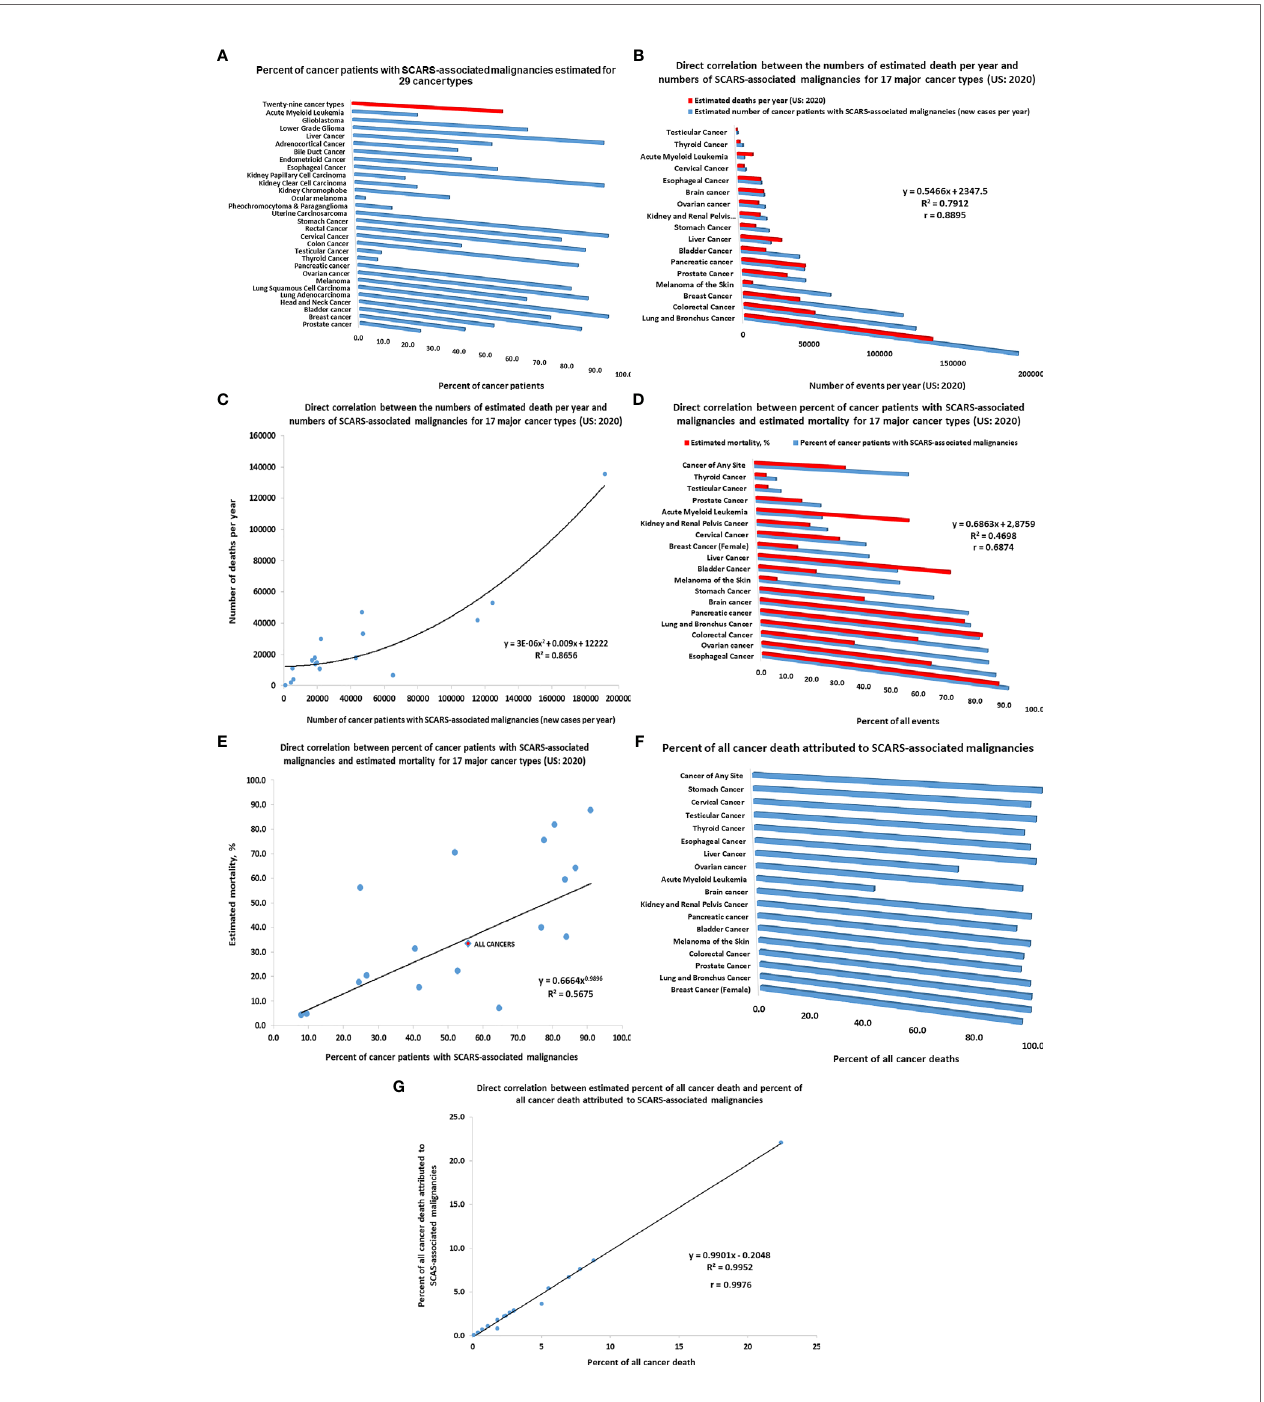
FIGURE 5 | Inference of potential global impacts of SCARS-regulated genes on distinct mortality of different types of human malignancies. (A) Percent of cancer patients with SCARS-associated malignancies estimated for 29 cancer types (adopted from Refs (52, 56, 90). (B) Direct correlation between the numbers of estimated death per year and numbers of SCARS-associated malignancies for 17 major cancer types (US: 2020). (C) Correlation plot illustrating a direct correlation between the numbers of estimated death per year and numbers of SCARS-associated malignancies for 17 major cancer types (US: 2020). (D) Direct correlation between percent of cancer patients with SCARS-associated malignancies and estimated mortality rates for 17 major cancer types (US: 2020). (E) Correlation plot illustrating a direct correlation between percent of cancer patients with SCARS-associated malignancies and estimated mortality rates for 17 major cancer types (US: 2020). (F) Percent of all cancer death attributed to SCARS-associated malignancies estimated for 17 major cancer types. Estimates of maximum values are reported which were calculated not to exceed the total number of estimated death for each cancer type. (G) Correlation plot illustrating a direct correlation between estimated percent of all cancer death and percent of all cancer death attributed to SCARS-associated malignancies for 17 major cancer